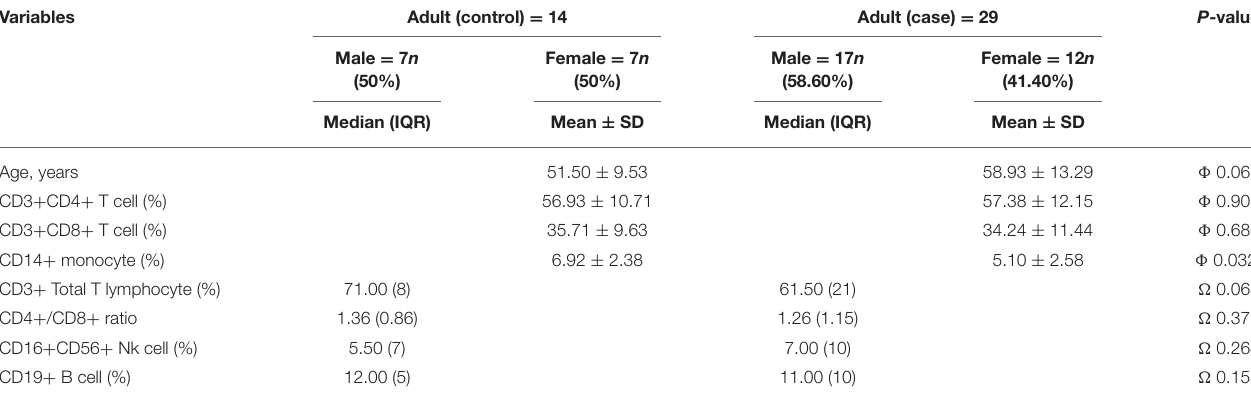
TABLE 4 | Comparison of peripheral innate and adaptive immune cells of COVID-19 adult patients with healthy adults.